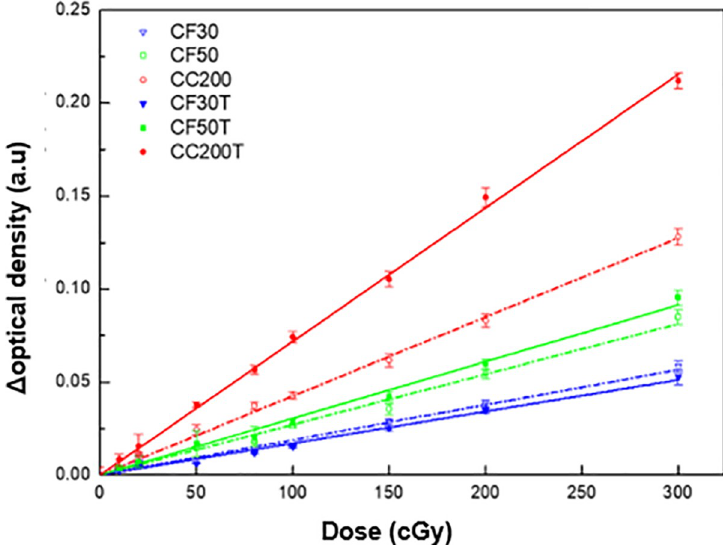
Fig 5. Optical density changes ( Δ OD) for each formulation as a function of the absorbed